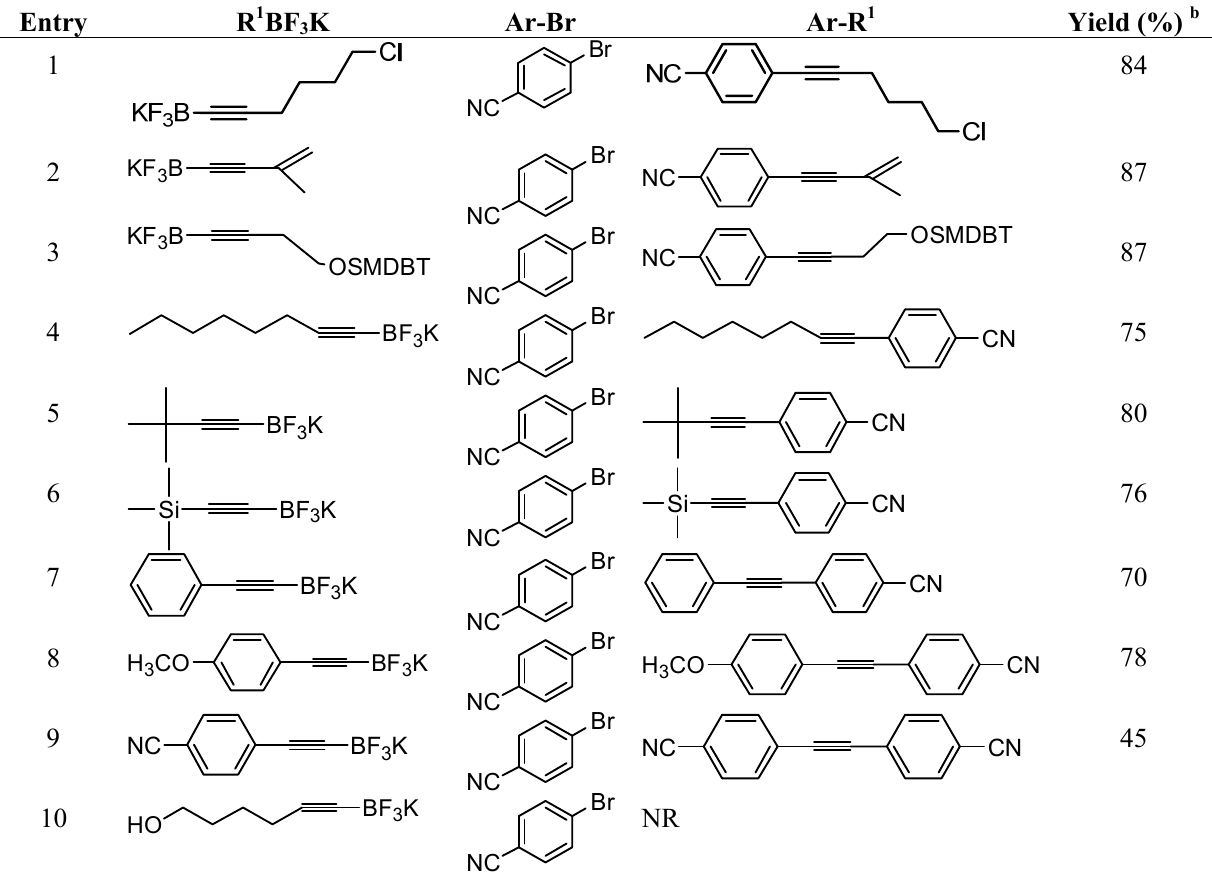
Table 2. Cross-coupling reactions of alkynyltrifluoroborates with 4-bromobenzonitrile a .